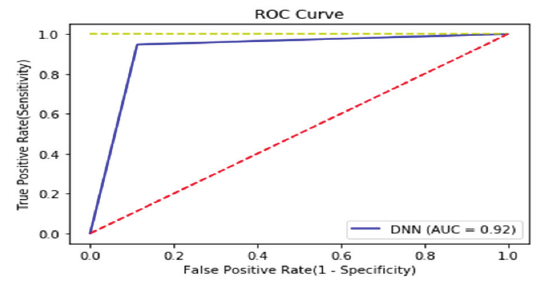
Figure 12. ROC curve of Windows binary.